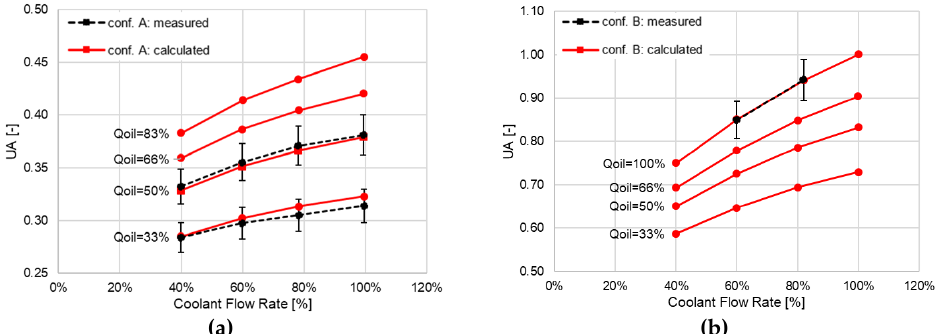
Figure 23. Overall heat transfer coefficient for different coolant and oil flow rate (red: Calculated; black: Measured): ( a ) Cooler A and ( b ) cooler B. Results are normalized with respect to the maximum value of the dataset (cooler B, Q oil = 100%, Q cool = 100%).